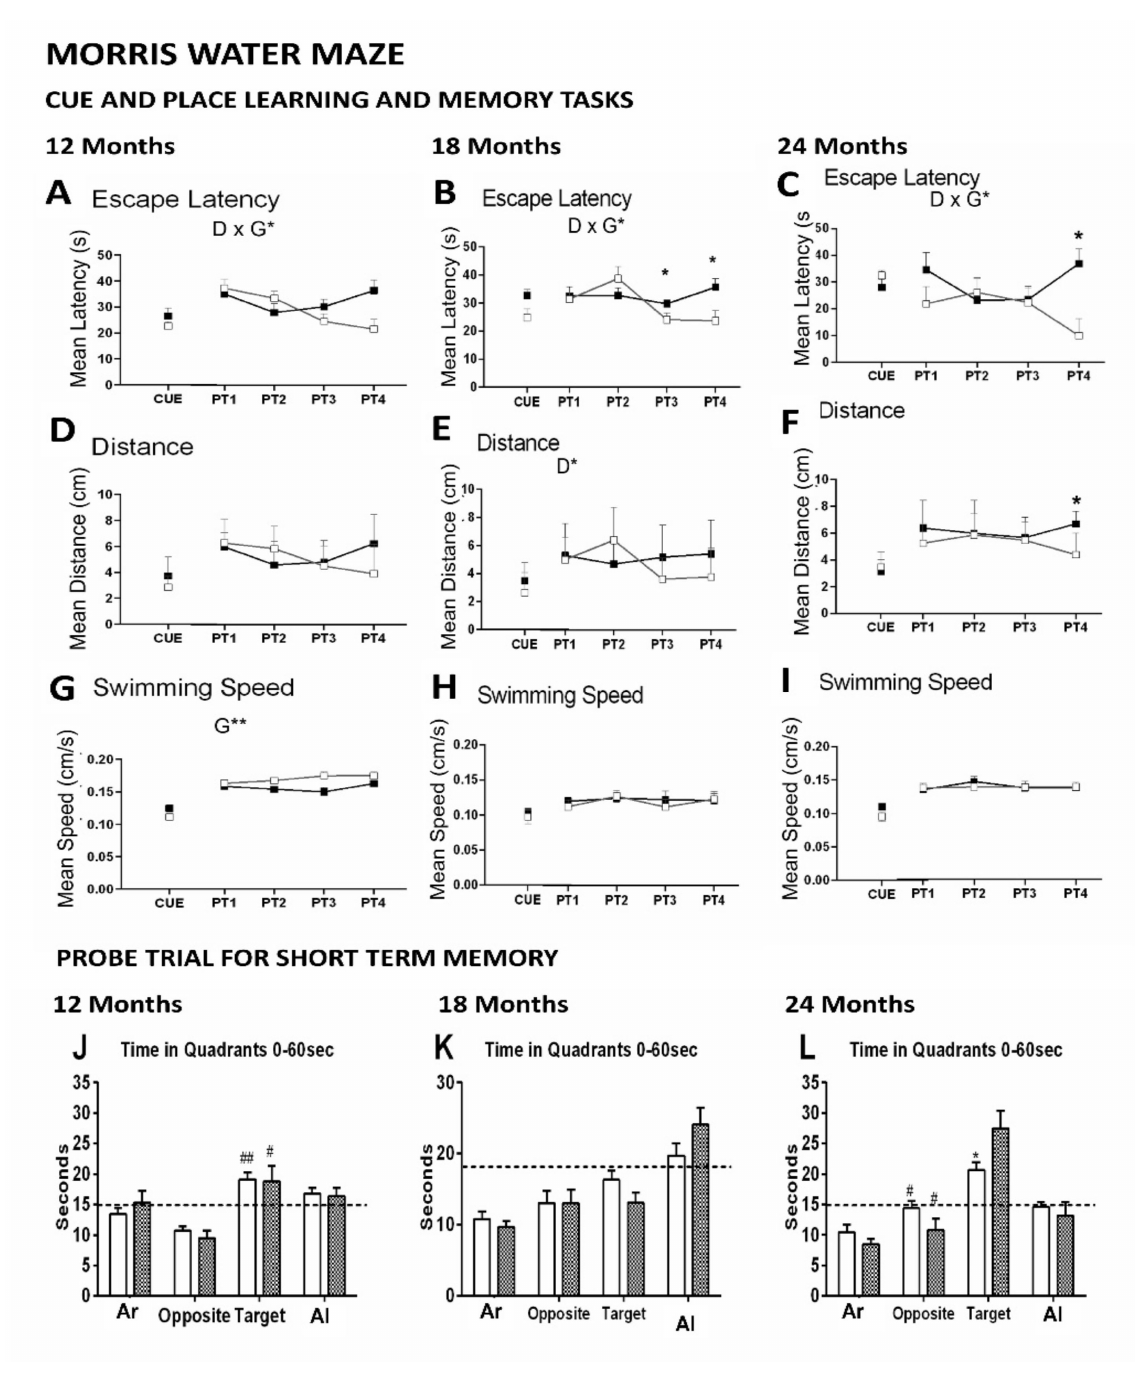
Figure 5. Quantitative analysis of the performance of wildtype (WT) and APP23 mice at 12, 18, and 24 months of age in three paradigms of the MWM. Data are expressed by means ± SEM. Day-by-day quantitative analysis of the CUE and PT place leaning task by means of ( A – C ) mean escape latency, ( D – F ) distance and ( G – I ) swimming speed. Open squares or bars: WT mice; Solid squares or bars: APP23 mice. ANOVA, D, day factor; G, genotype factor, Post-hoc Student t -test; * p < 0.05, ** p < 0.01 vs. the corresponding control group. ( J – L ) Probe trial for short term memory assessed by means of the time in each quadrant; adjacent right (Ar), Opposite, Target and adjacent left (Al) quadrants. Statistics: Student t -test; * p < 0.05 vs. the corresponding control group. Target vs. opposite vs. # p < 0.05, ## p <